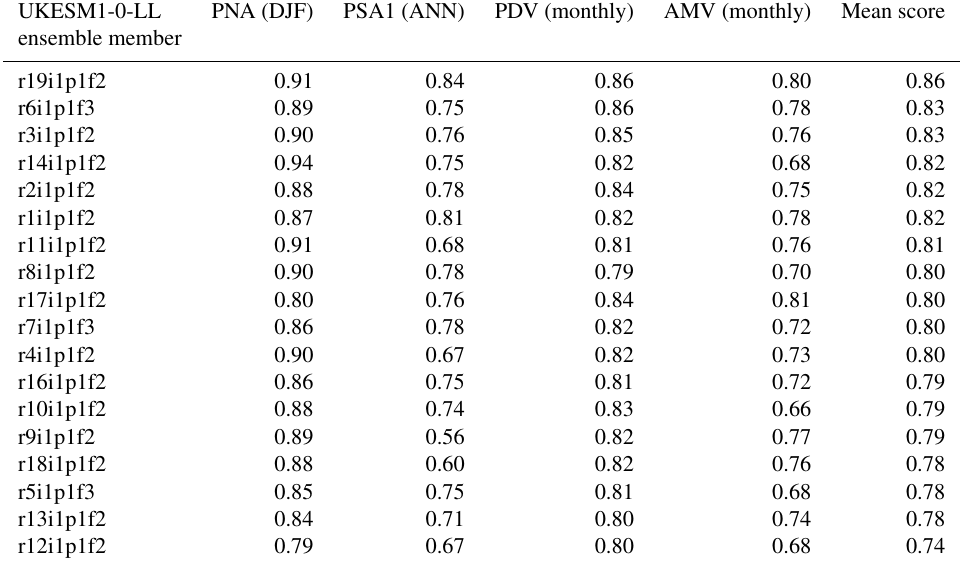
Table A2. Pearson correlation values obtained using 18 UKESM1-0-LL simulation with respect to the observed (ERA20C_ERA5, ERSSTv5) spatial patterns of PNA, PSA1, PDV and AMV and their mean score over the 1900–2014 period. Sorted by mean score.